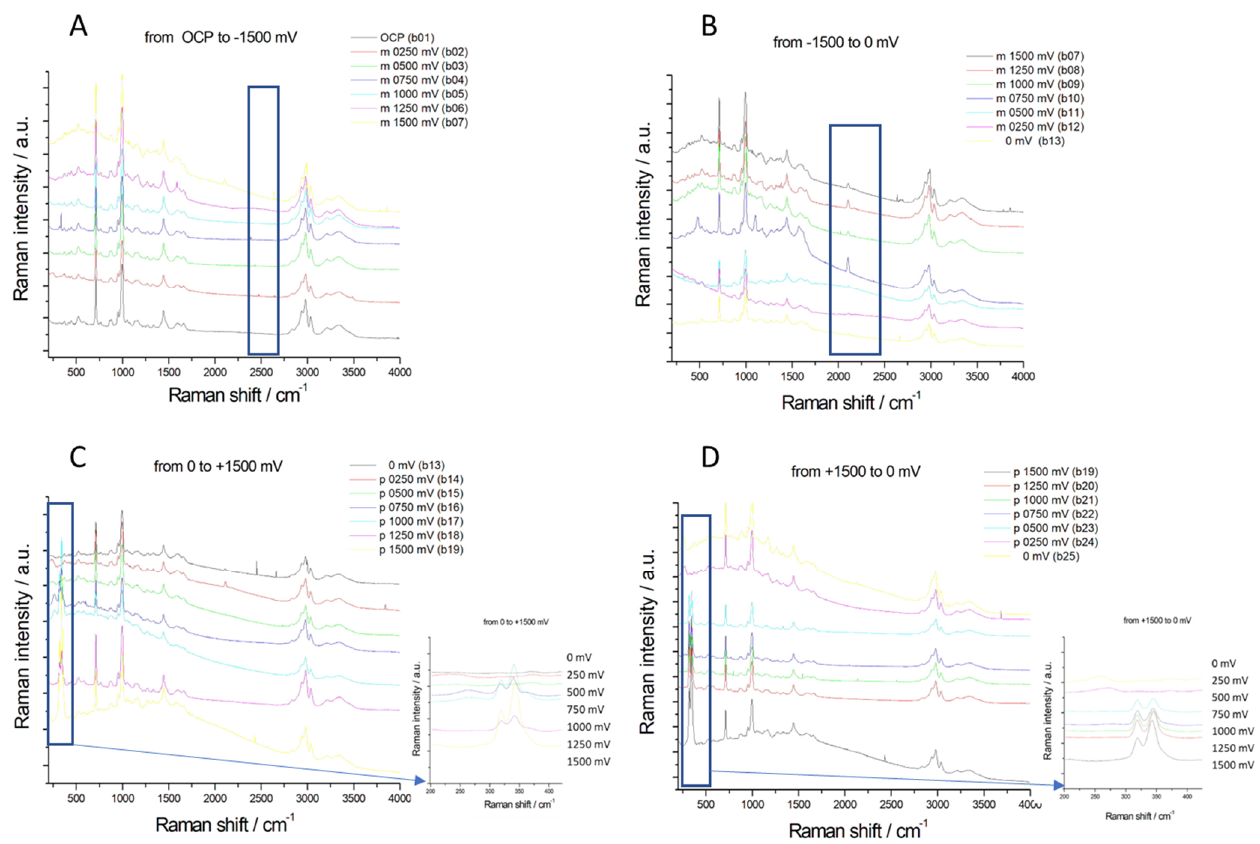
Figure 6. Potential-dependent in situ SERS spectra were measured at an Au electrode in contact with the DESU electrolyte. Panels ( A – D ) report the spectra recorded in the whole measured range. Blue rectangles highlight diagnostic spectral ranges.